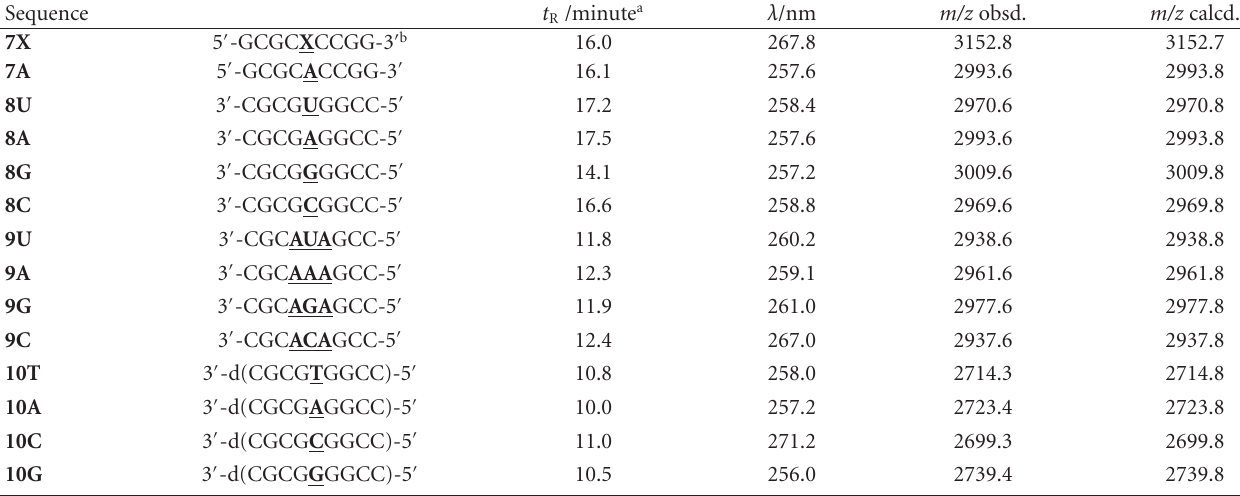
Table 1: The sequences, RP-HPLC retention times, wavelengths of UV absorption maxima, and observed and calculated molecular weights of the oligonucleotides